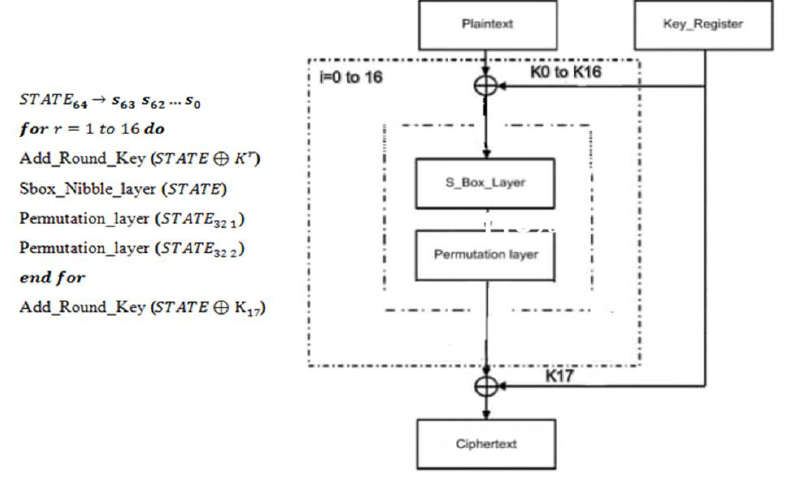
Figure 1. SLA Block diagram.